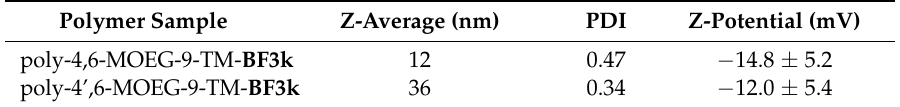
Table 3. DLS results obtained with poly-4,6-MOEG-9-TM- BF3k and poly-4’,6-MOEG-9-TM- BF3k in ultrapure water at 25 °C. Reported data are those recorded after 2 days (sample concentration 0.2 mg/mL).